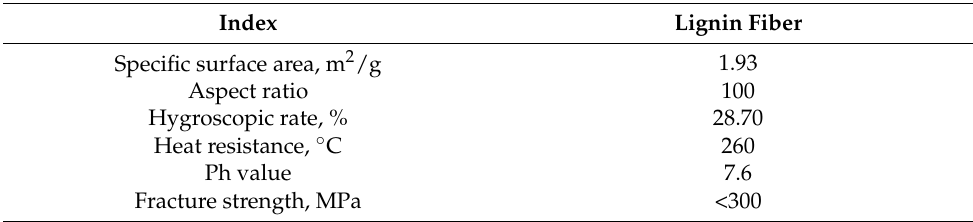
Figure 1. Photo of lignin fiber. Table 2. Properties of lignin